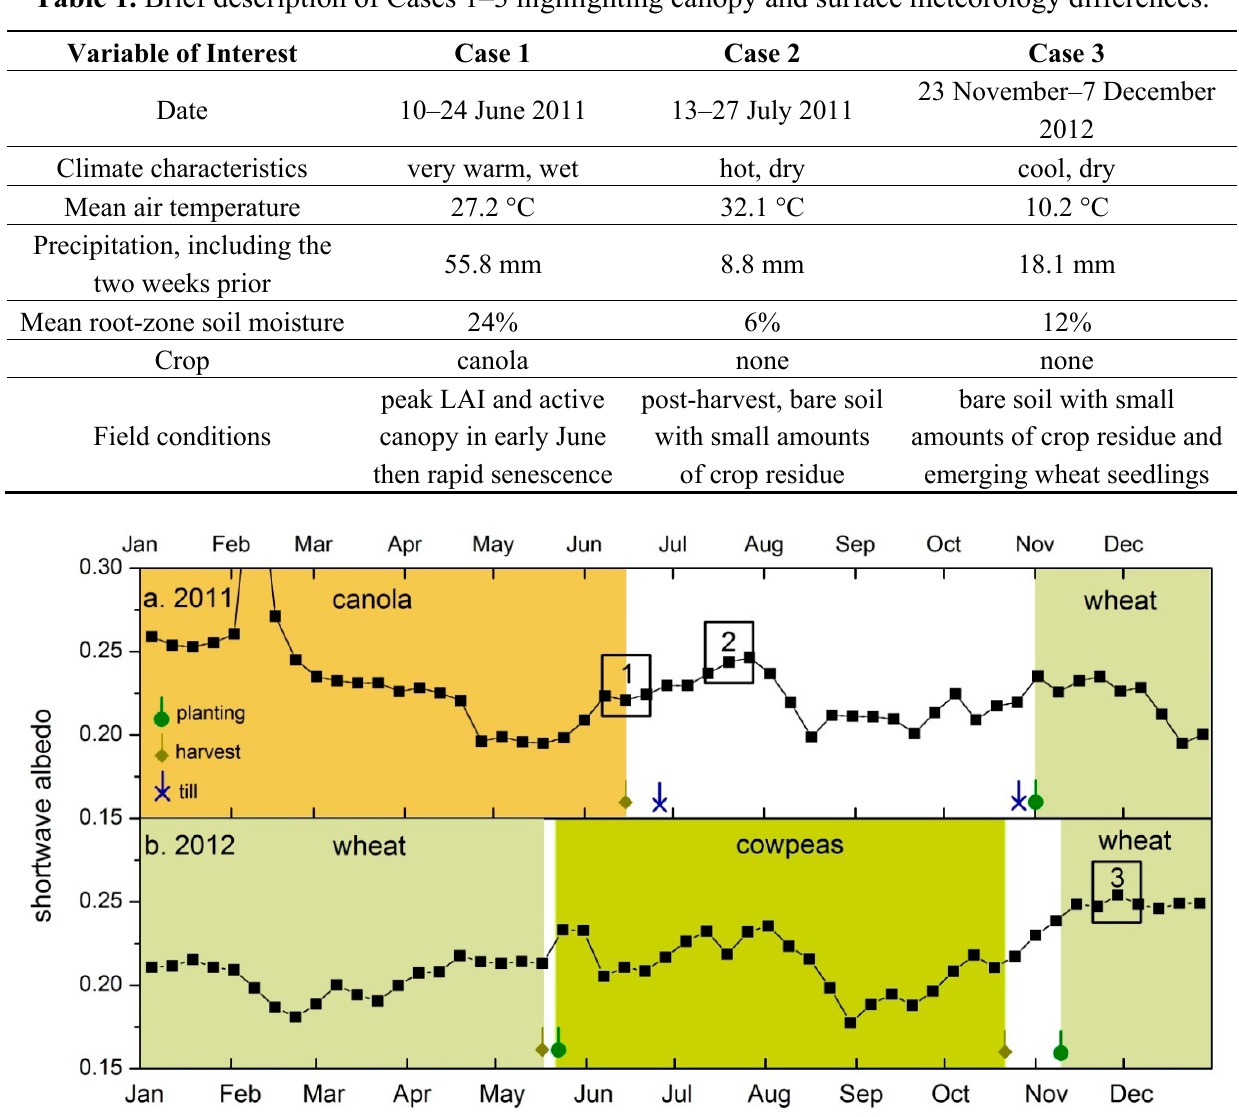
Figure 2. Time series of measured mean weekly albedo at the SGP ARM Central Facility in ( a ) 2011 and ( b ) 2012. Variations in albedo indicate changes in the surface canopy. Each growing season is shaded with a color depending on crop species. Also shown is the timing of planting, harvest and till events. Boxes 1–3 indicate the timing of simulated case periods. Note the differences in albedo between the case studies. The spike in albedo in February 2011 is due to snow